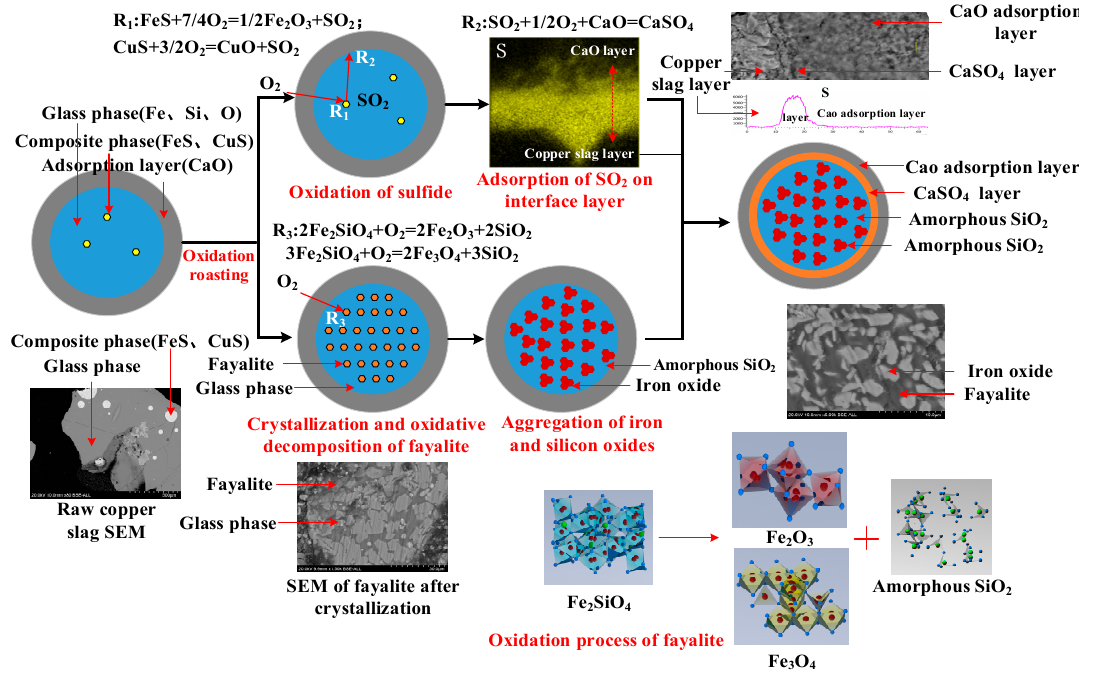
Figure 13. Reaction mechanisms of high-sulfur copper slag composite agglomerate in oxidation- roasting process. roasting